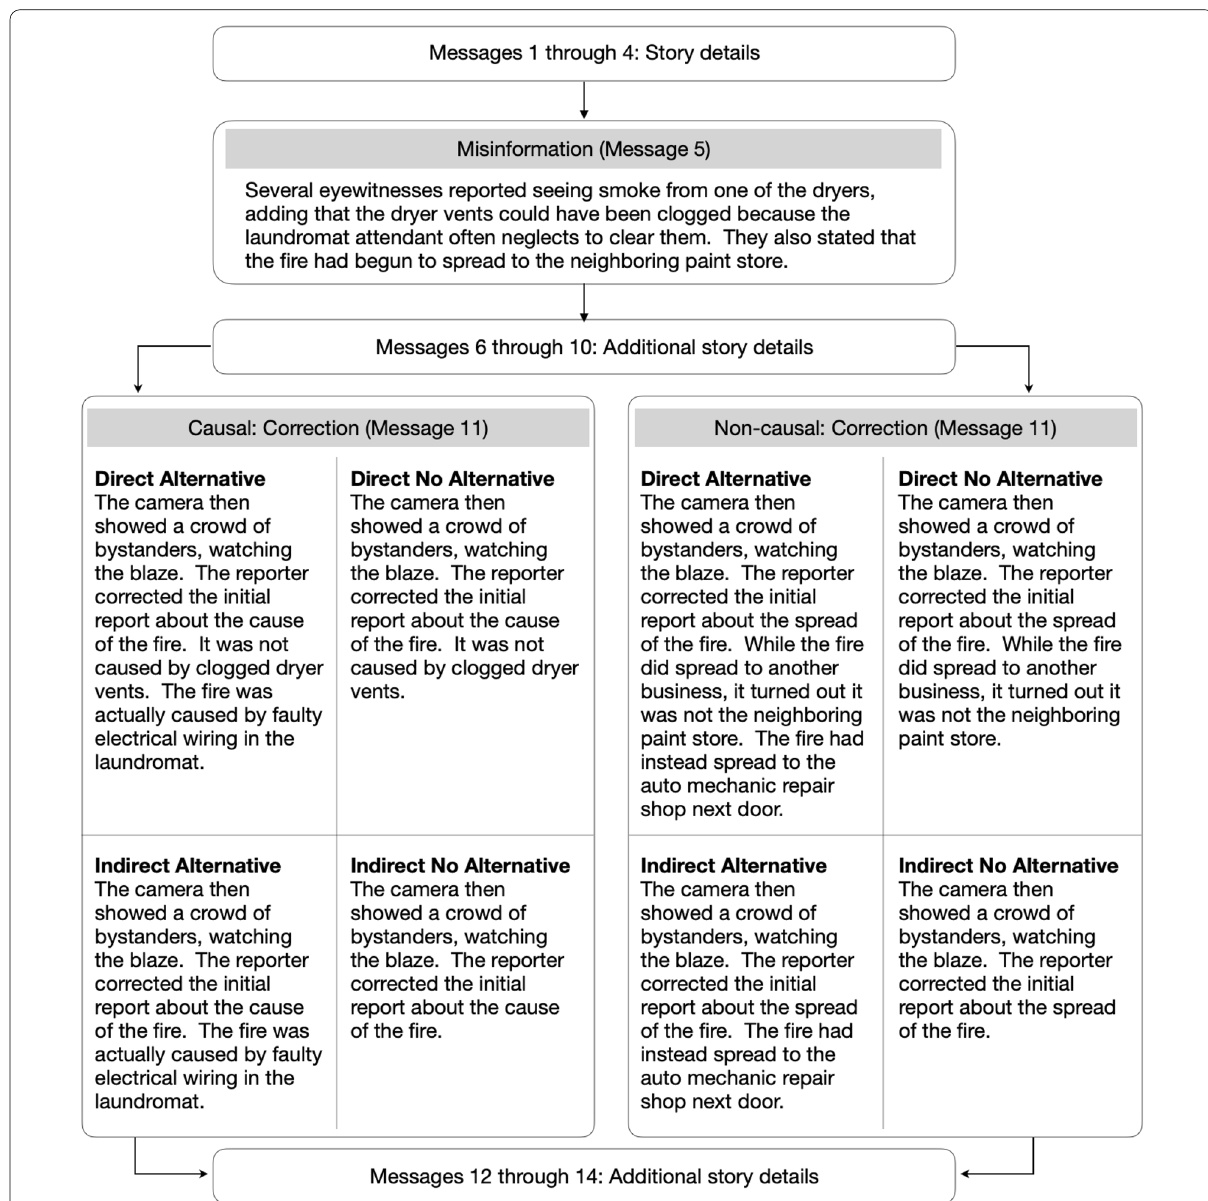
Fig. 5 Summary of message sequence and story details for experimental conditions in Experiment